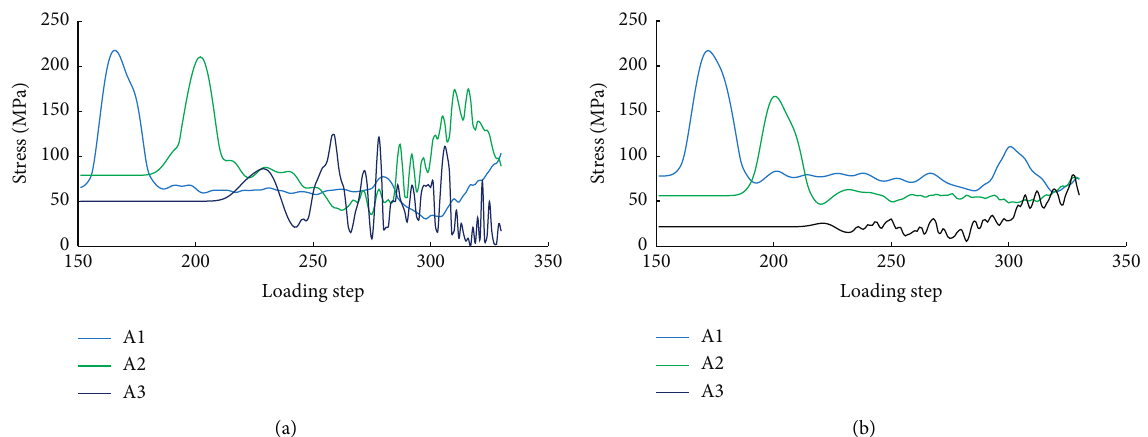
Figure 8: Stress characteristics of points A1, A2, and A3 in the two numerical models. (a) Numerical model without bolt. (b) Numerical model with